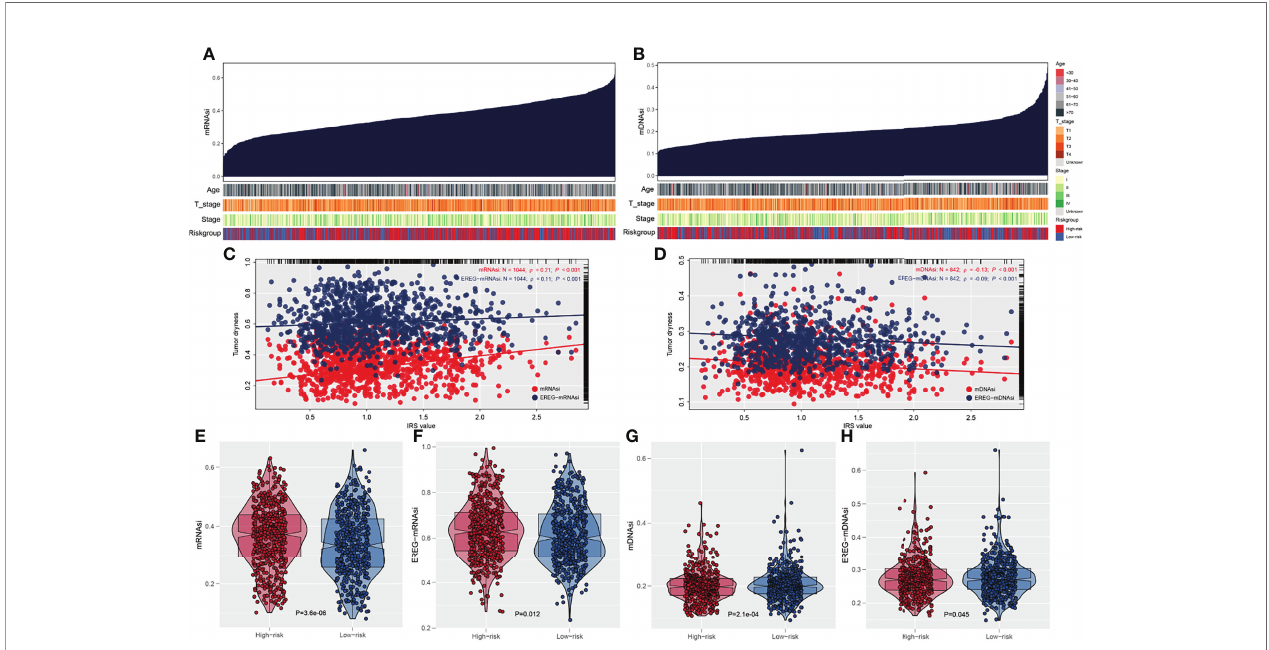
FIGURE 7 | Association of tumor stemness with IRS. (A) Quanti fi cation of tumor stemness in RNA level; (B) Quanti fi cation of tumor stemness in DNA level; (C, D) The association between IRS and tumor stemness; (E, F) A higher degree tumor stemness in RNA level was observed in high risk patients; (G, H) A lower degree tumor stemness in RNA level was observed in high risk